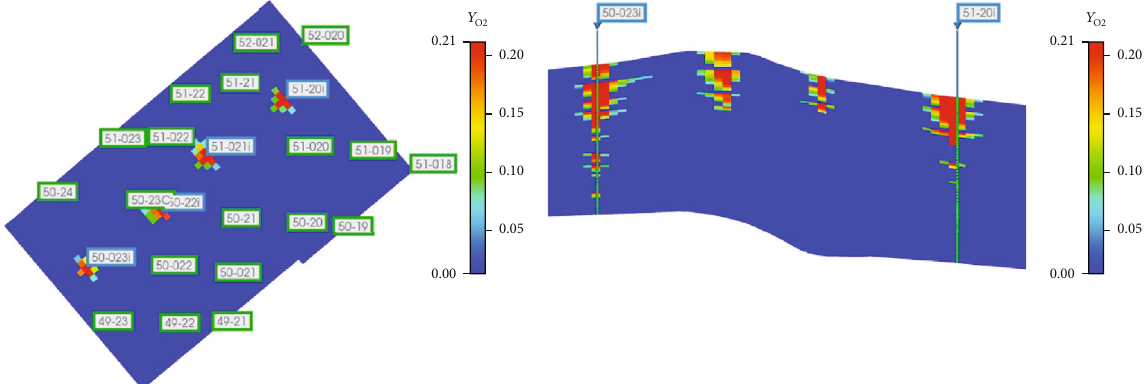
Figure 21: Prediction of ISC process O mole fraction in gas phase for the D block sector model (layer 10 and reservoir cross-section, 2